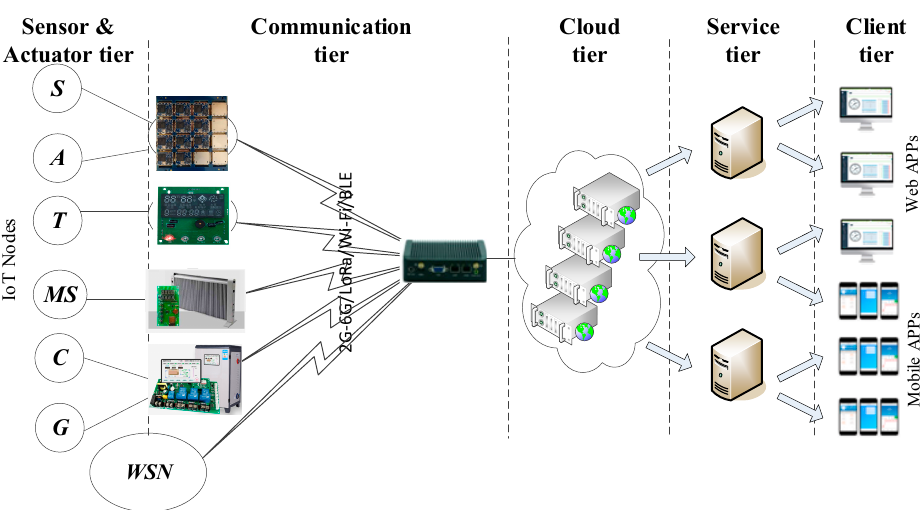
Figure 3. The main part of the IoT multitier architecture of EMULSION.